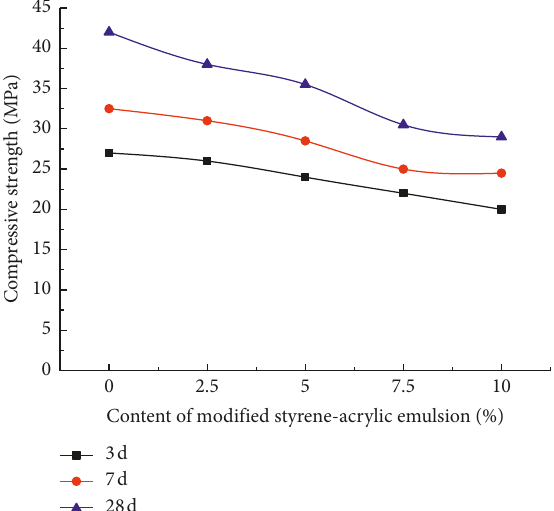
Figure 15: Influence of the modified styrene-acrylic emulsion on the compressive strength of the solidified cement